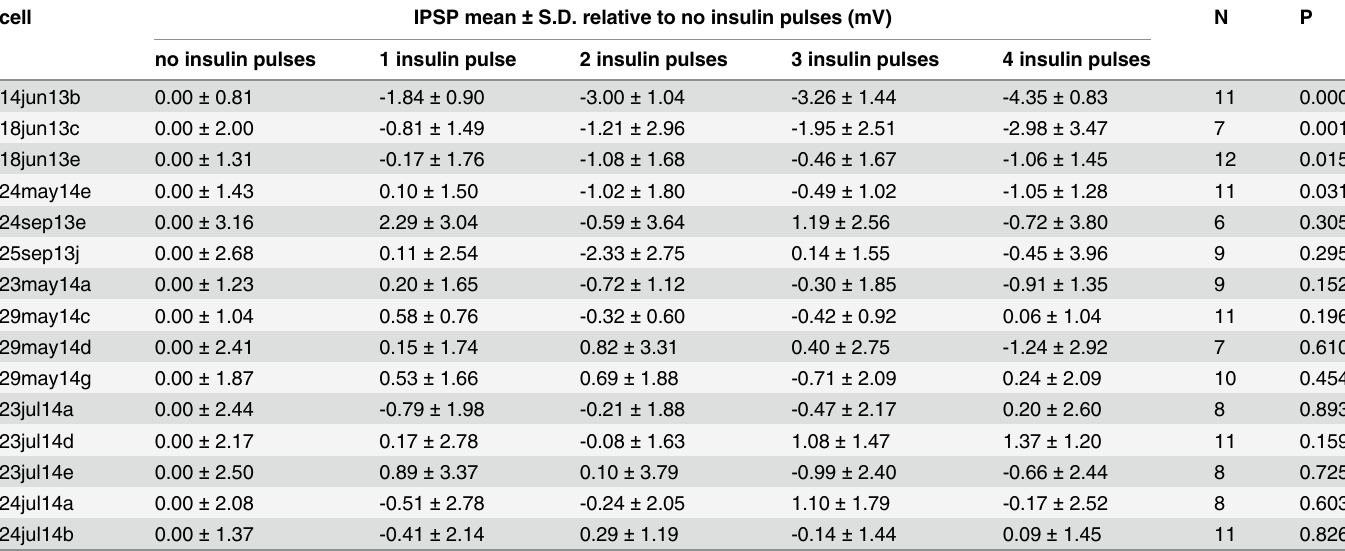
Table 2. Membrane potential changes in Kiss1 neurons in response to